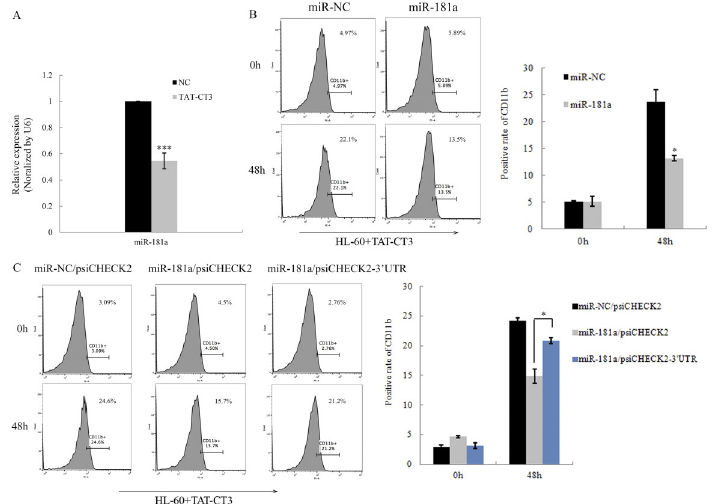
Figure 4. Functional analysis of miR-181a in HL-60 cell differentiation. A , qPCR analysis of miR-181a in HL-60 cells following 2 days of exposure to TAT-CT3 at a concentration of 50 m g/mL. B , Flow cytometry analysis of CD11b expression in HL-60 cells transfected with miR-181 mimic and mimic control. C , Flow cytometry analysis of CD11b expression in the "rescue" assay. Data are reported as means ± SD. *P o 0.05; ***P o 0.001 (ANOVA or Student ’ s t